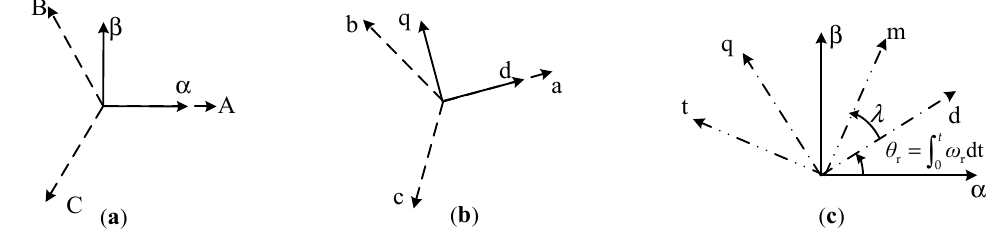
Figure 1. Schematic diagram of BDFM.